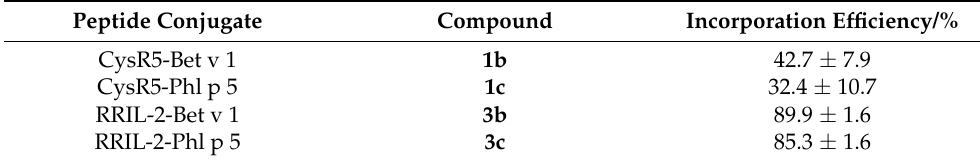
Table 2 . Peptide incorporation efficiency of peptide–antigen conjugates. Table 2. Peptide incorporation efficiency of peptide–antigen conjugates.